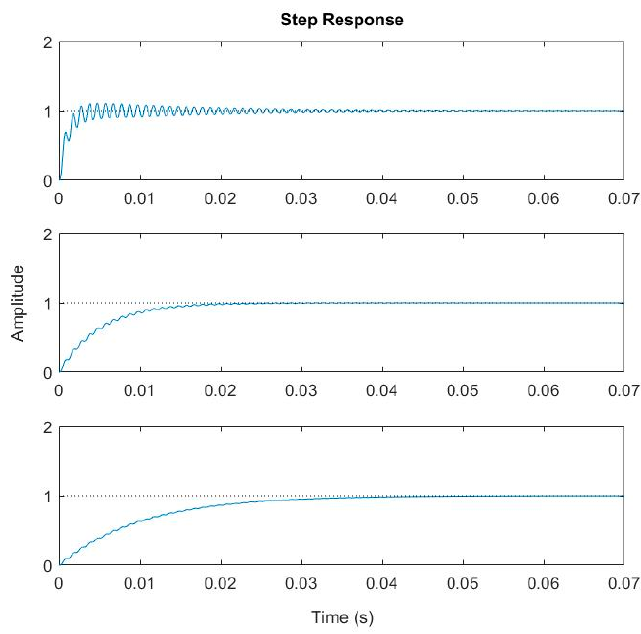
Figure 5. Step response with fixed resonant frequency of 1 kHz and different thermal time constants ( τ = 1, 5, 10 ms).